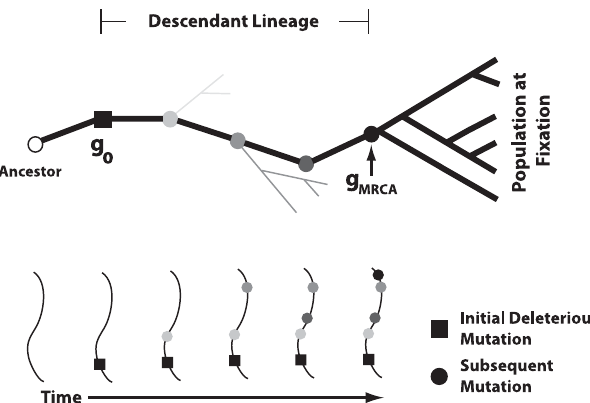
Figure 1. Diagram Depicting a Simplified ‘‘ Descendant Lineage ’’ for a Genotype Carrying a Deleterious Mutation (Black Square) That Fixed in the Population The genealogy of the population present at fixation is used to determine the MRCA. The descendant lineage is the single genotypic line of descent from the initial mutant genotype to g MRCA . The faint gray branches along the descendant lineage represent lineages that go extinct. The bottom half of this figure shows the accumulation of mutations in the genotypes comprising the descendant